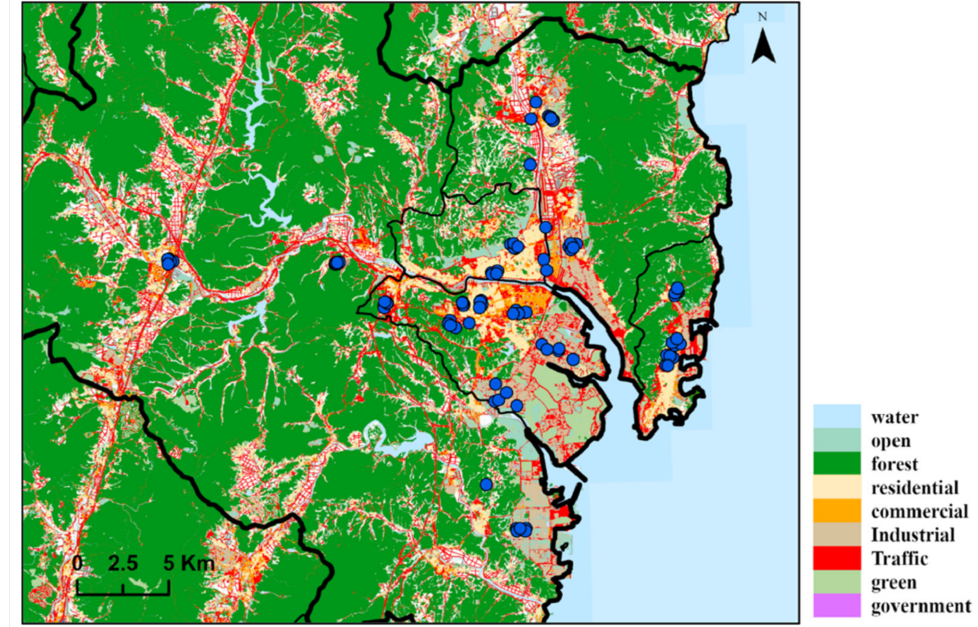
Figure 3. The area depicted by land use and 87 noise monitoring sites in